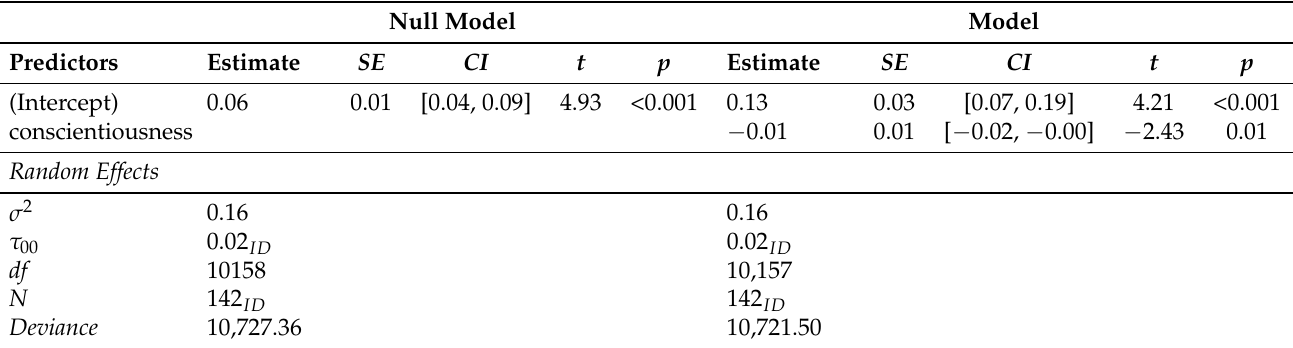
Table A12. Mixed model of the influence of conscientiousness on the emospace widget response in the arousal dimension.